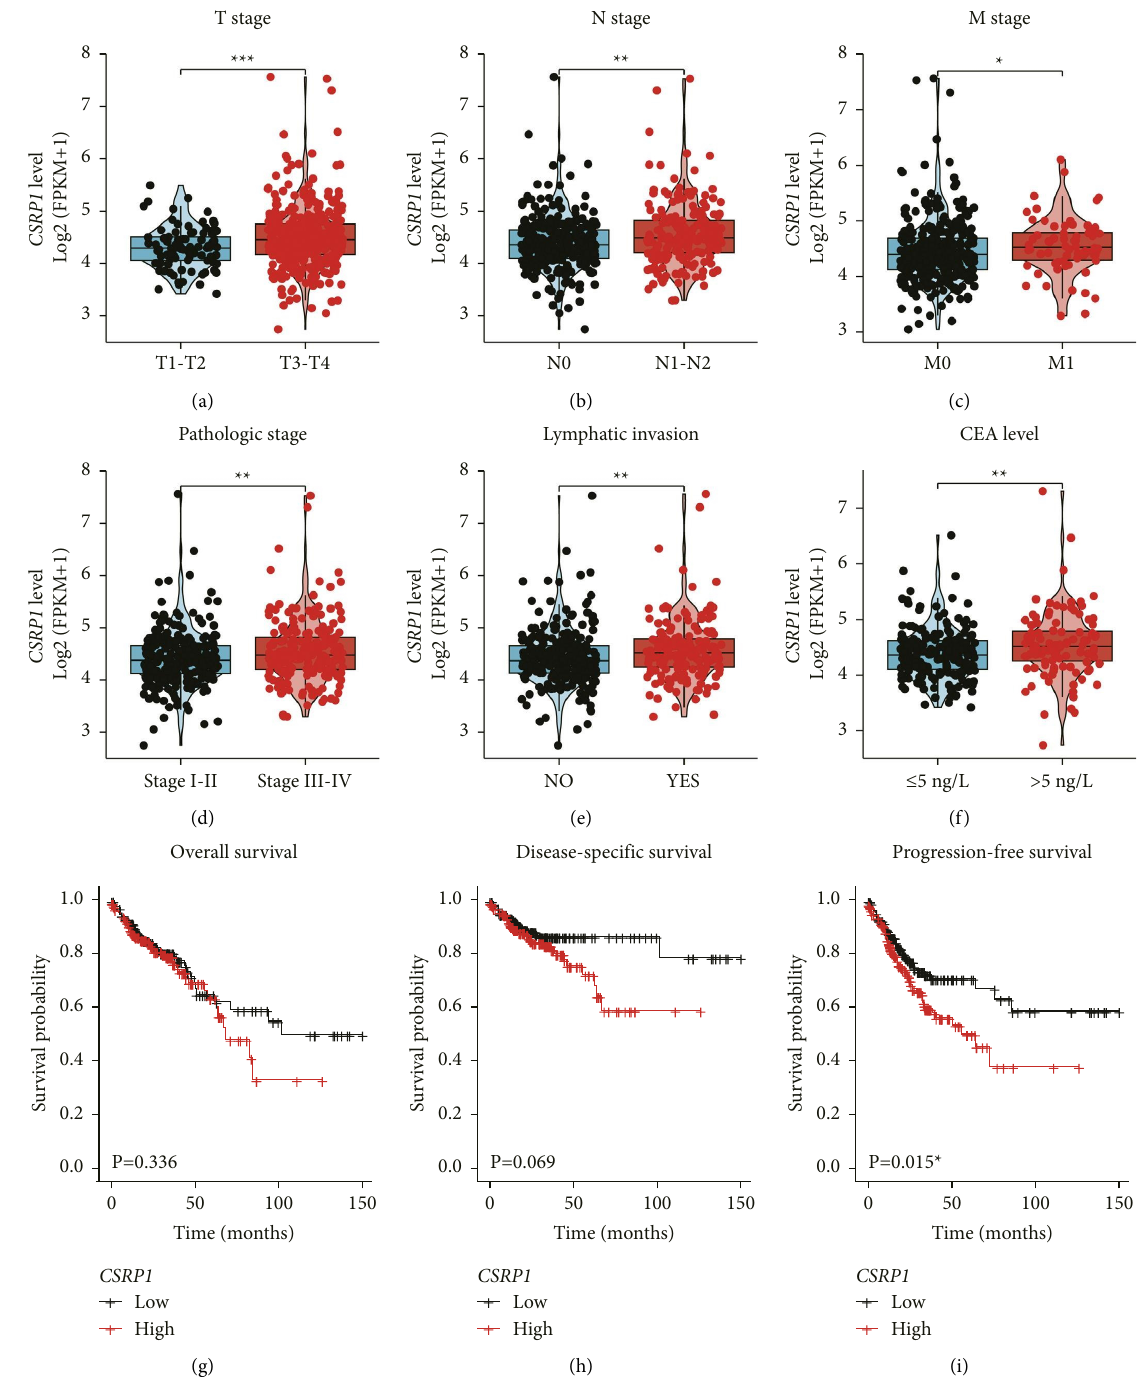
Figure 1: Te mRNA level of CSRP1 in TCGA-COAD datasets and its clinical signifcance. Te mRNA level of CSRP1 in COAD tissues was extracted from TCGA dataset. By unpaired student’s t -test, we found that CSRP1 was positively correlated with COAD T stage (a), N stage (b), M stage (c), TNM stage (d), lymphatic invasion (e), and CEA level (f) In addition, we subgrouped TCGA patients into low-CSRP1 group and high-CSRP1 group to further assess its efect on COAD overall survival (g), disease-free survival (h), and progression-free survival (i),